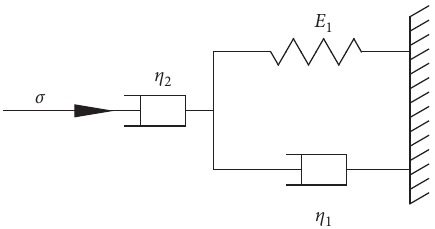
Figure 4: The simplified Burgers model without an elastic element in